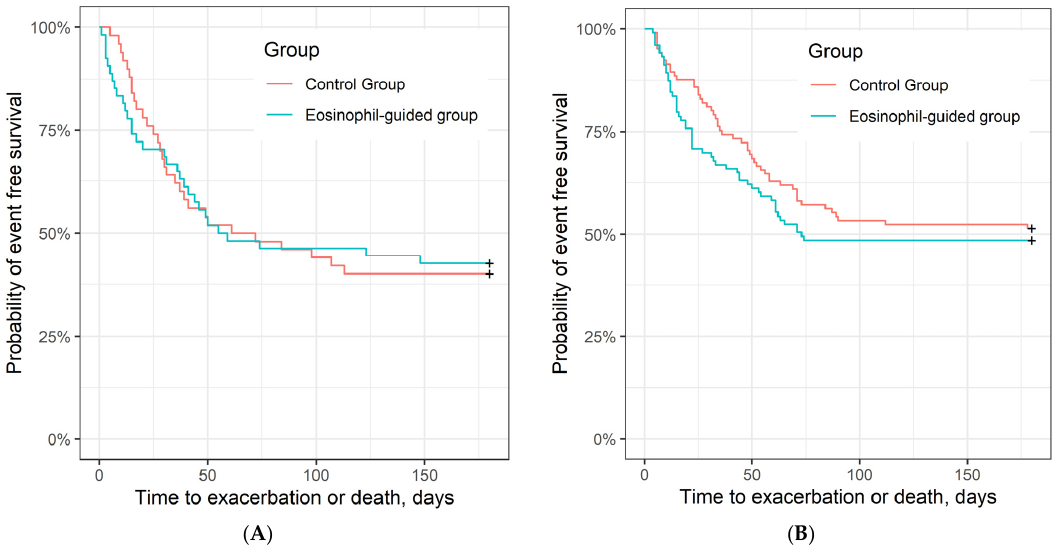
Figure 3. Time to exacerbation or death (unadjusted). ( A ) Kaplan–Meier curve of time to exacerbation or death in control group and eosinophil-guided group in current smokers, HR = 0.99 (95% CI, 0.60–1.64), p = 0.98 (log-rank test) and ( B ) in ex-smokers, HR = 1.17 (95% CI, 0.8–1.72); p = 0.43.